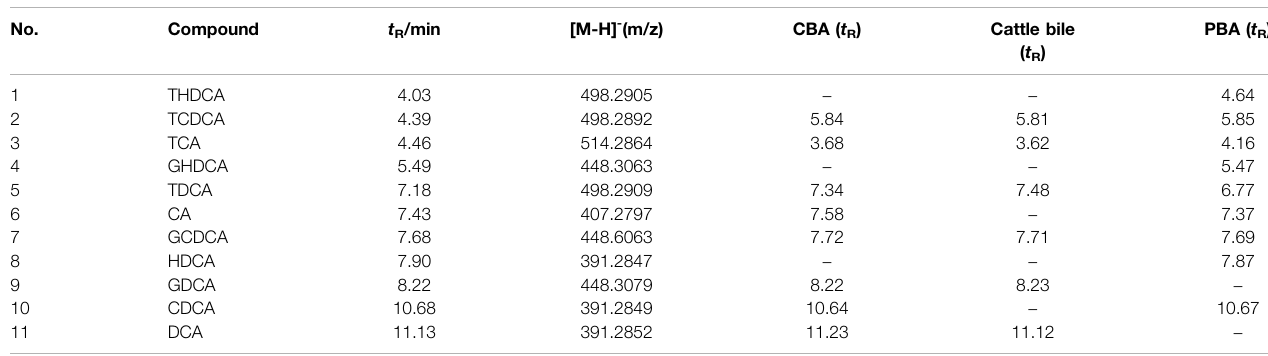
TABLE 2 | The identi fi ed bile acids from CBA, PBA, and cattle bile.